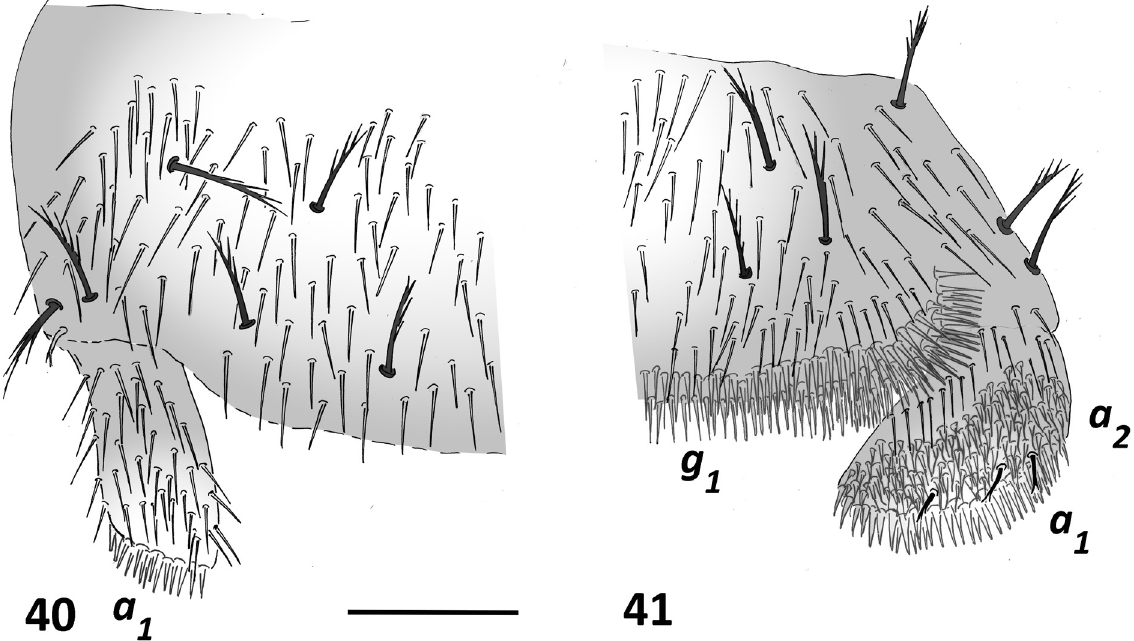
Figs 40–41. Campodea ( Campodea ) lubbockii Silvestri, 1912, from Pichoy, France. 40 . ♀, 5 mm, first urosternite. 41 . ♂, 4.5 mm, first urosternite. Abbreviations: a